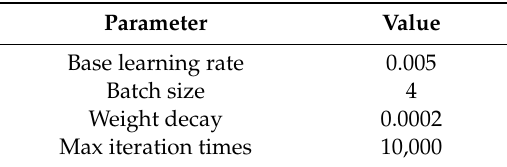
Table 2. Training Parameters.